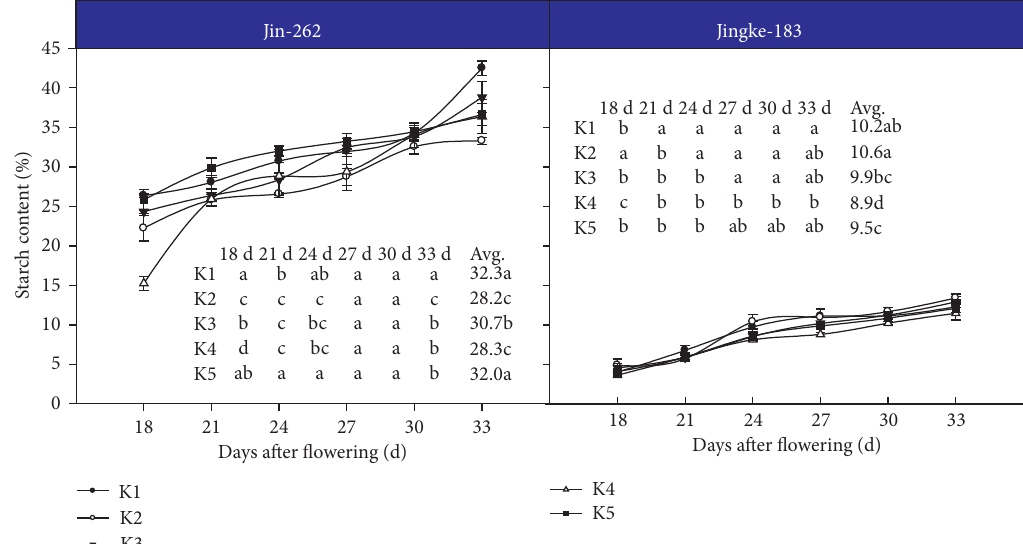
Figure 6: Effects of potassium on the starch content of fresh-eaten maize kernels. The different lowercase letters are significant differences at the 5% level; AVG, average; the bars are standard deviation ( n � 5). Table 5: Effect of potassium fertilizer on the yield of fresh-eaten maize during 2018. Varieties